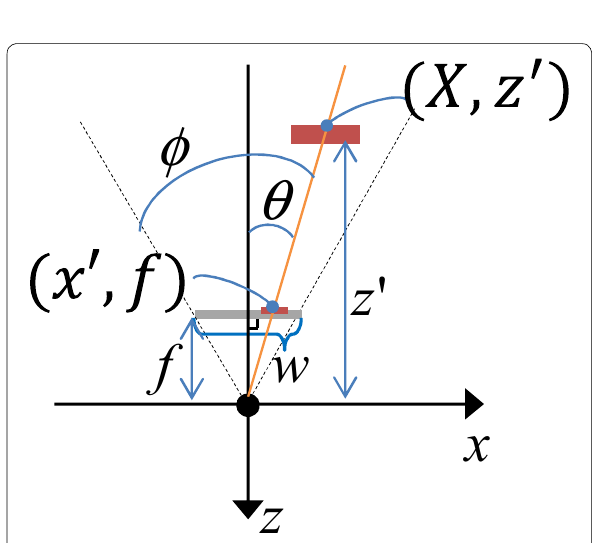
Fig. 22 Diagram of camera coordinate system used in our robot navigation